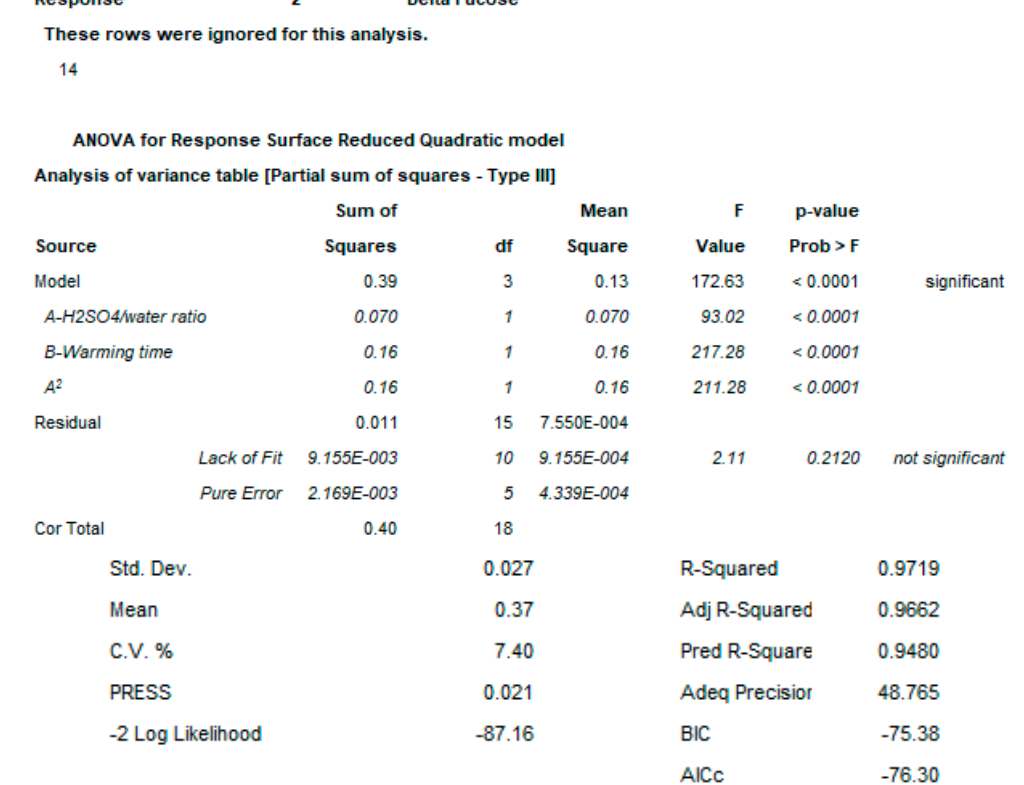
Figure A2. DoE statistical analysis for fucose response surface in Dische colorimetric method.